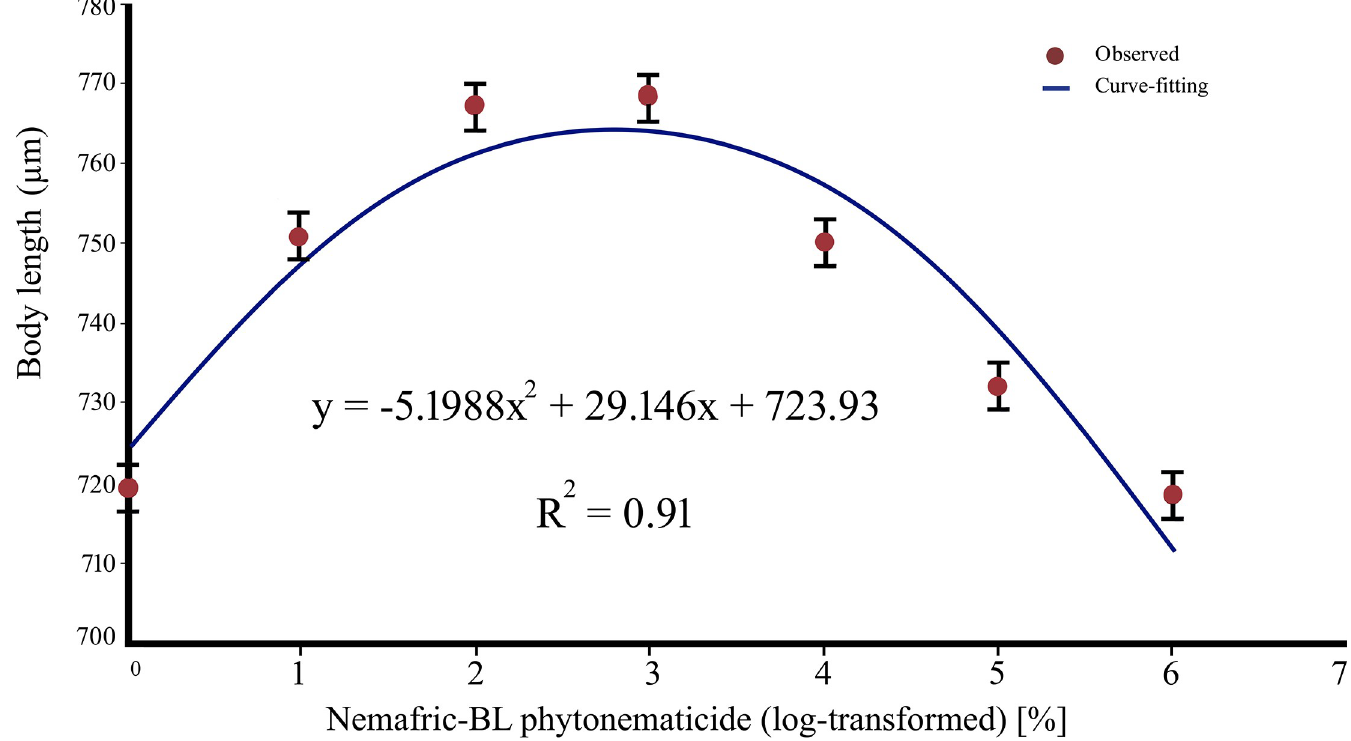
Fig 2. Positive quadratic curve for Steinernema feltiae body length against Nemafric-BL phytonematicide, with log-transformed (untransformed) extremum at 2.80% (5.60%).